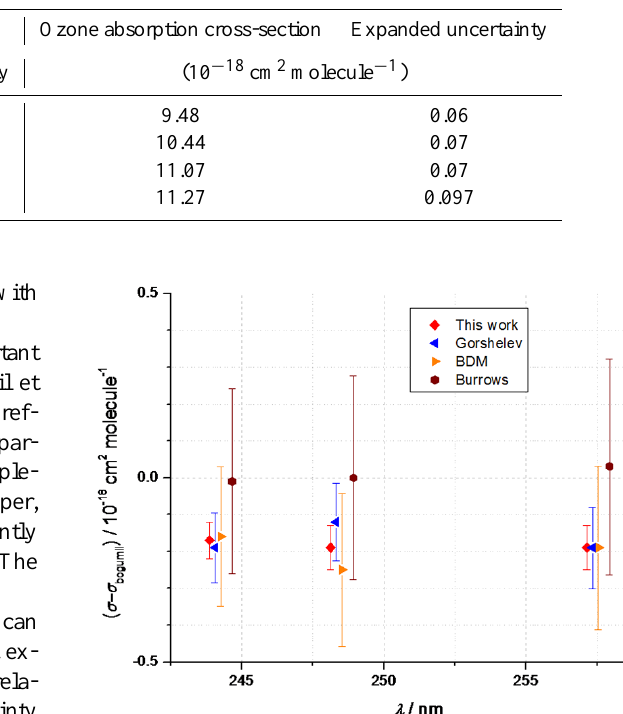
Figure 8. Comparison between the ozone absorption cross-section values measured by different groups at the three laser wavelengths examined in this study. Data were taken from the recent publication of Gorshelev et al. (2014) and the values measured by Bogumil et al. (2003) are subtracted from the other values. Wavelengths are plotted with a 0.2nm shift from each other for